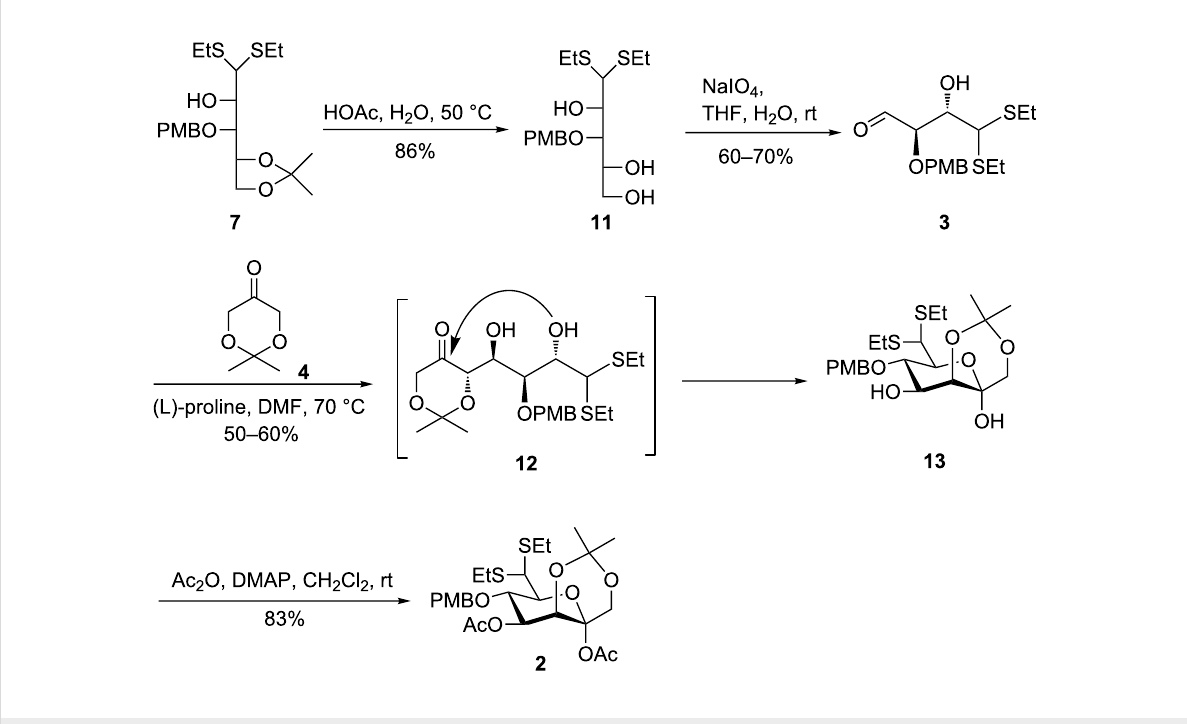
Scheme 3: Synthesis of differentially protected ketoheptose building block 2